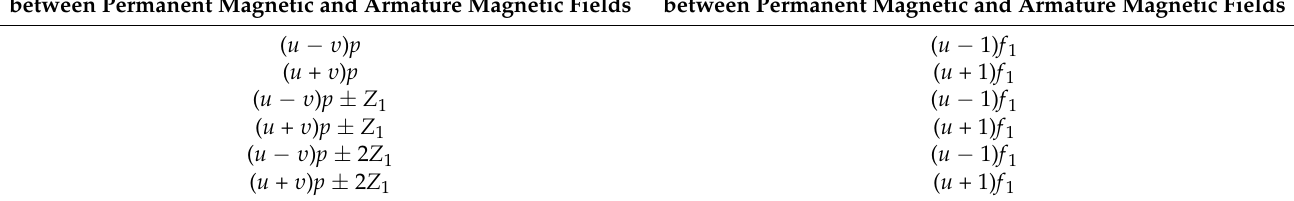
Table 3. Number of electromagnetic force waves and frequency.